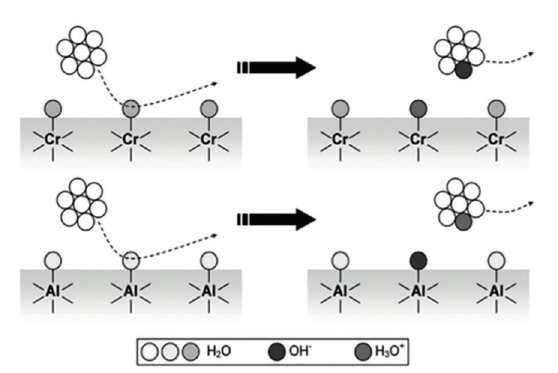
Figure 6 - how water contributes charge to solid surfaces (hygroelectricity). Upper: a cluster of water molecules approaches a basic surface of stainless steel or other chromium alloy that contains basic chromium oxide at the surface. The oxide picks h+ ions, acquiring positive charge. Aluminum metal is coated with acidic oxide that picks up Oh- ions, acquiring negative charge. Reprinted (adapted) with permission from (Ducati et al. 2010). Copyright 2010 American Chemical